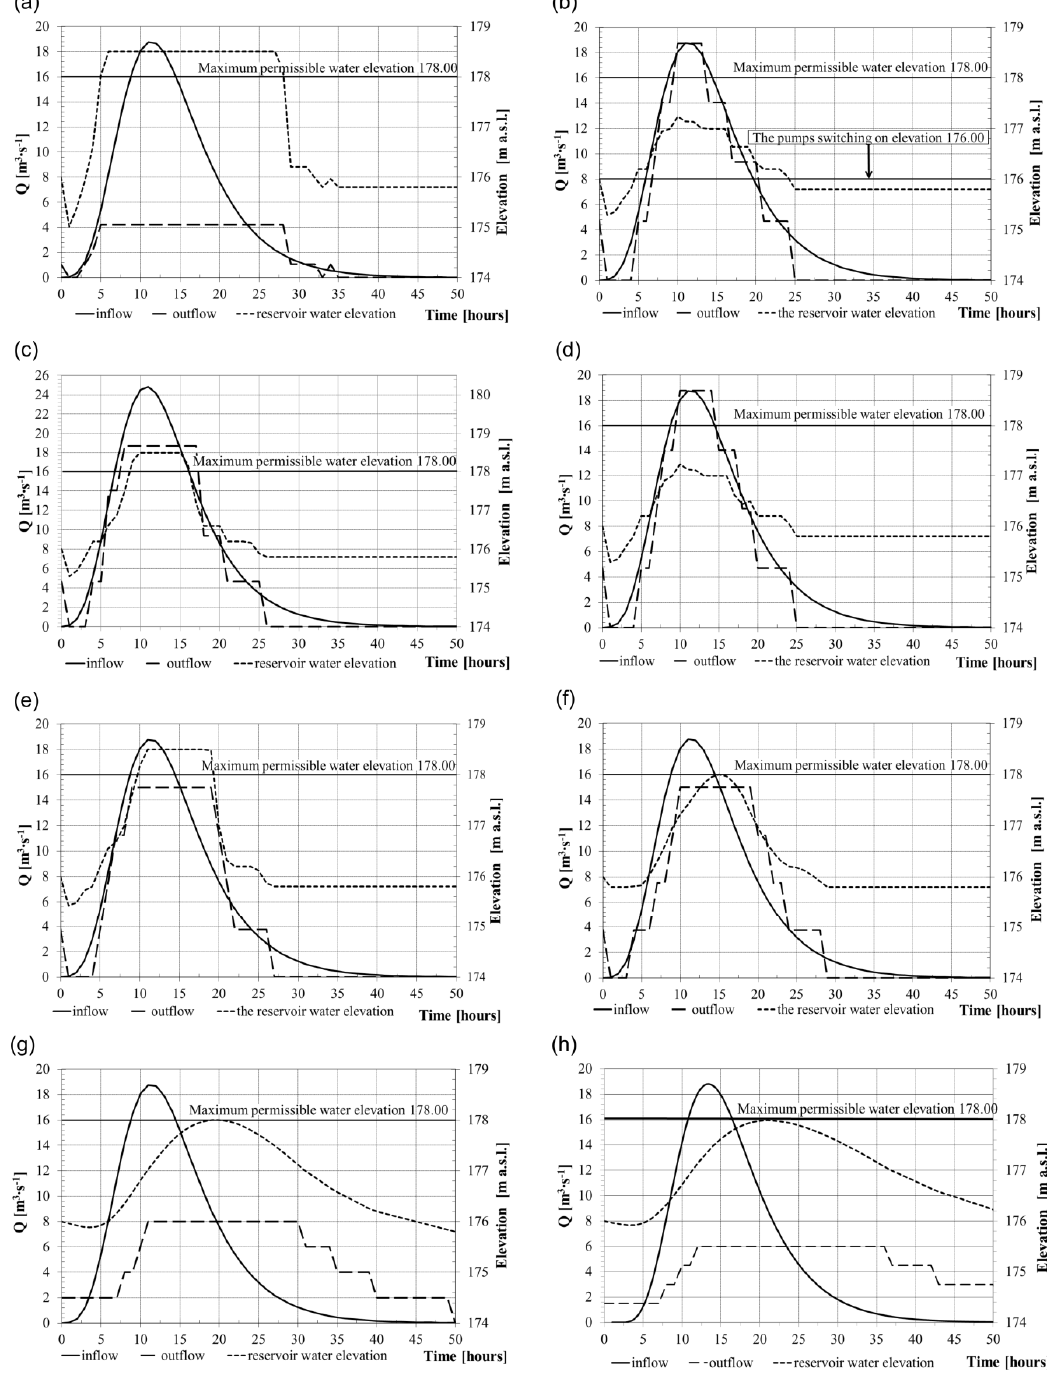
Figure 5. Flood wave transformation in ( a ) Case 1; ( b ) Case 3; ( c ) Case 4; ( d ) Case 5; ( e ) Case 6; ( f ) Case 7; ( g ) Case 8; and ( h ) Case 9.